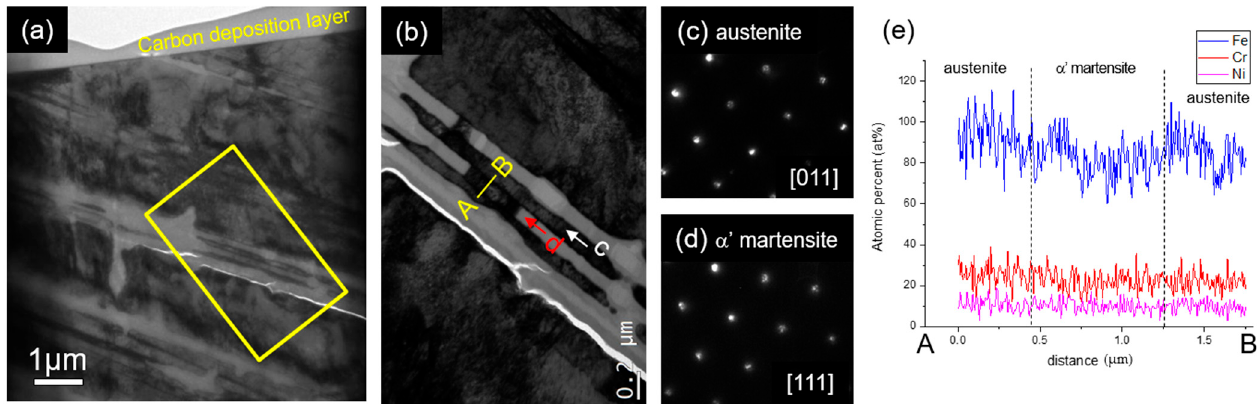
Figure 8. Low magnification BF TEM image is obtained from the area with micro crack. ( b ) TEM BF image enlarged from the region indicated by yellow rectangle in ( a ). ( c , d ) Electron diffraction pattern obtained from regions denoted by c and d in ( b ), respectively. ( e ) Line profile of the chemical composition obtained along the austenite/ α ’ martensite/austenite indicated with A-B in ( b ).